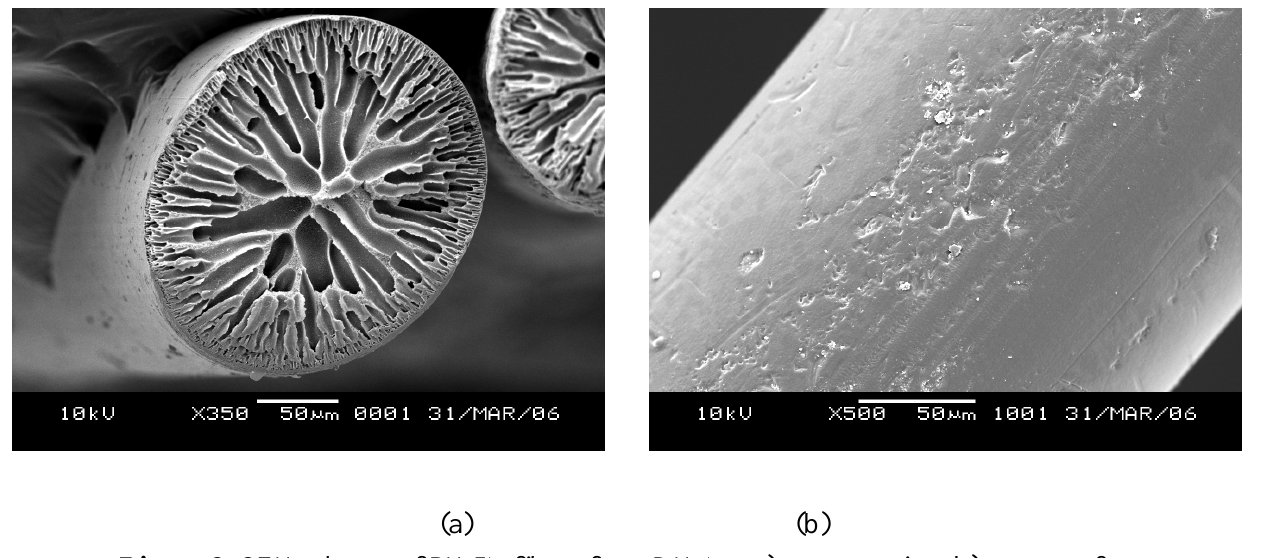
Figure 3. SEM photos of PMIA fibers from DMAc; a) cross-section, b) outer